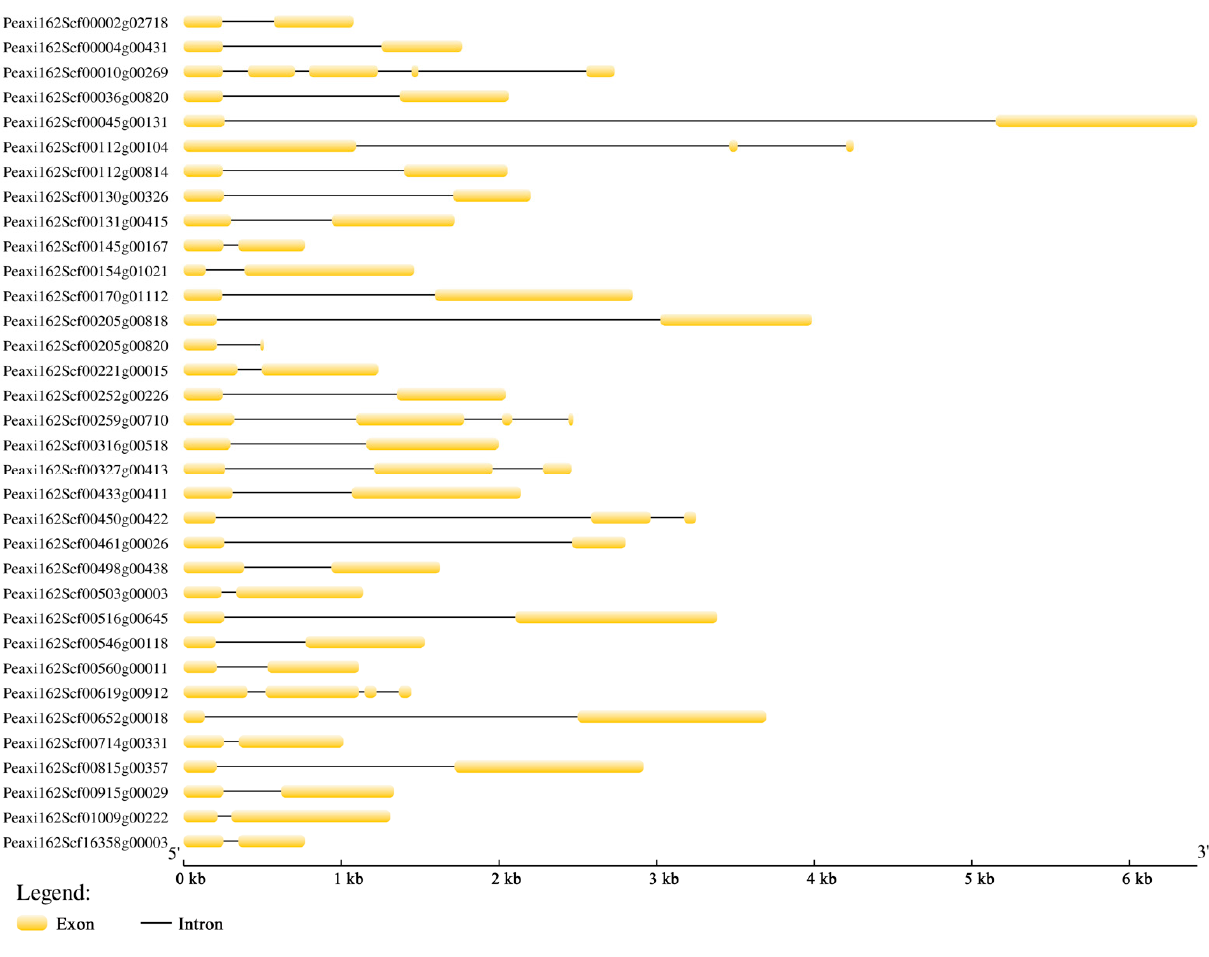
were also divided into three major subfamilies with 21 HSF proteins from A. thaliana , HSFA (red), HSFB (blue), and HSFC (green), which is shown in Figure 2. The HSFA sub- family is the largest with 23 petunia HSFs, while there are only two petunia HSFs in the HSFC subfamily. Among the HSFA subfamily, eight HSFs belong to class A9, followed by four HSFs in classes A1. However, none of the petunia HSFs belongs to class A7.